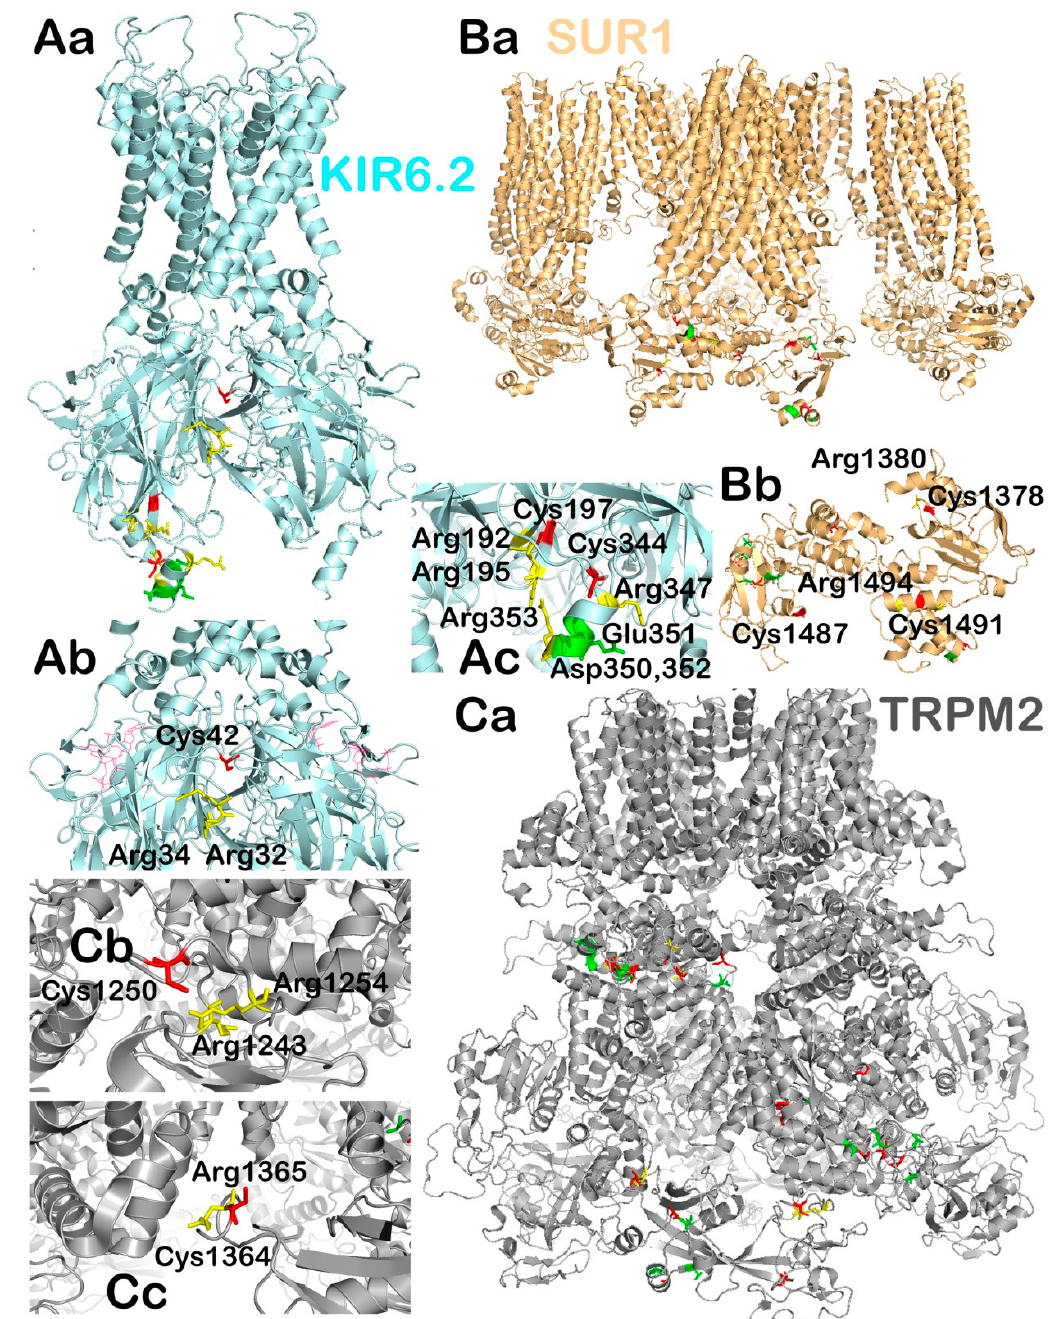
Figure 4. Predicted cysteines interacting with H 2 O 2 in KIR6.2, SUR1 and TRPM2 structures in pancreatic β -cells. Synthetic structure of mouse/hamster pancreatic ATP-sensitive potassium channel (pdb code 5wua) [133] and human TRPM2 bound to ADPR and calcium (pdb code 6pus) [157] were used for the visualization of the potential redox reactive cysteines. ( Aa , Ab , Ac ) Tetrameric assembly of KIR6.2 subunits (light blue) and details of potentially redox regulated Cys with surrounding Arg and/or Asp and Glu, modulating the Cys reactivity towards redox modifications in intracellular regions of the channel; ( Ba , Bb ) prediction of hypothetical redox regulated Cys within one intracellular domain of the SUR1 subunit (light orange) with Arg and Asp/Glu in close proximity and ( Ca , Cb , Cc ) human TRPM2 (light grey) and detailed visualization of hypothetical redox regulated Cys in intracellular domains; color coding: Cys in red, Arg in yellow, Asp and Glu in green .